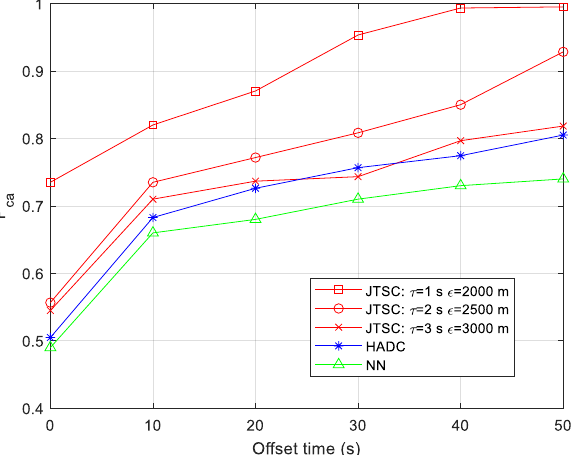
Figure 10. Probability of correct association vs. different offset times.